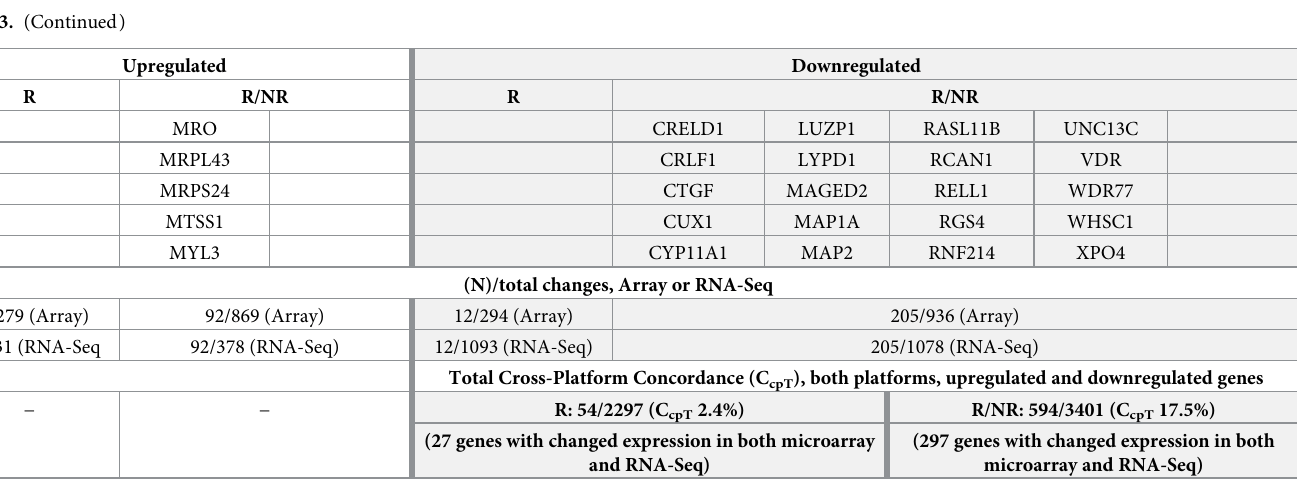
microarray and RNA-Seq (Table 3) yielded a total of 27 genes in the R analysis (15 upregulated and 12 downregulated), for a C for any gene expression change of 2.4%. cpT R/NR analysis. In the R/NR analysis microarray identified 1805 genes with changed expres- sion (9.2% of total mRNAs measured, 869 upregulated and 936 downregulated, P = 0.11), while RNA-Seq detected 1456 changes (9.5% of total measured transcripts), of which 378 were upregulated and 1078 downregulated (P < 0.0001). The R/NR dataset exhibited 297 changes that were concordant between microarray and RNA-Seq (92 upregulated and 205 downregu- lated (P < 0.0001)) (Table 3), with a combined platform C of 17.5% (P < 0.0001 vs. A-S R/ cpT NR (PCR/microarray) C of 62%). The within S-R C comparison between candidate (6/ cpT cpT 16, 38%) and global changes measured by microarray/RNA-Seq yielded a P value of 0.036. Table 4 contains a biologic categorization of genes with concordantly changed expression for the microarray/RNA-Seq R/NR analysis in the S-R cohort, with the category assignments